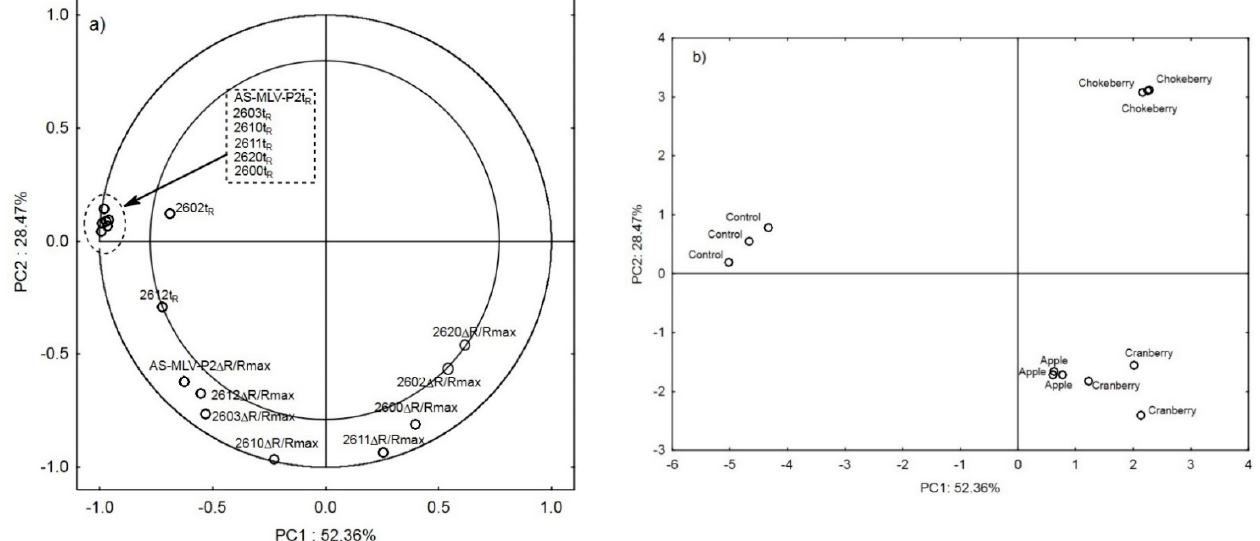
Figure 2. ( a ) Projection of the variables: electronic nose responses to the PC1 and PC2 factor plane; ( b ) projection of the cases of supplementing bread with chokeberry fiber, apple fiber, cranberry fiber, and for control bread to the PC1 and PC2 factor plane.